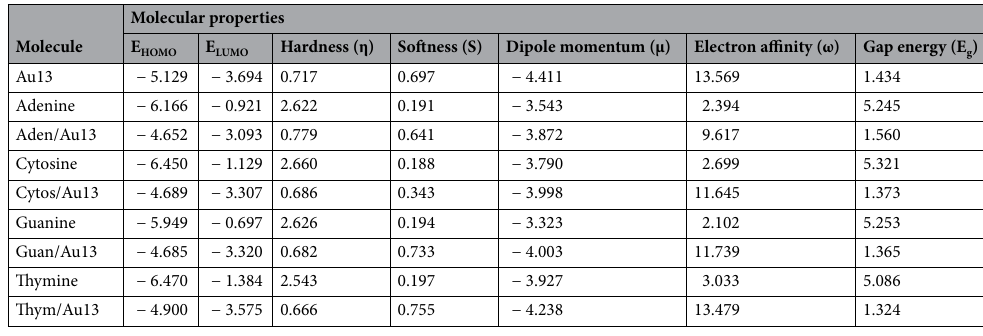
Table 2. Molecular properties of nucleobases and nucleobases / Au13 complexes.